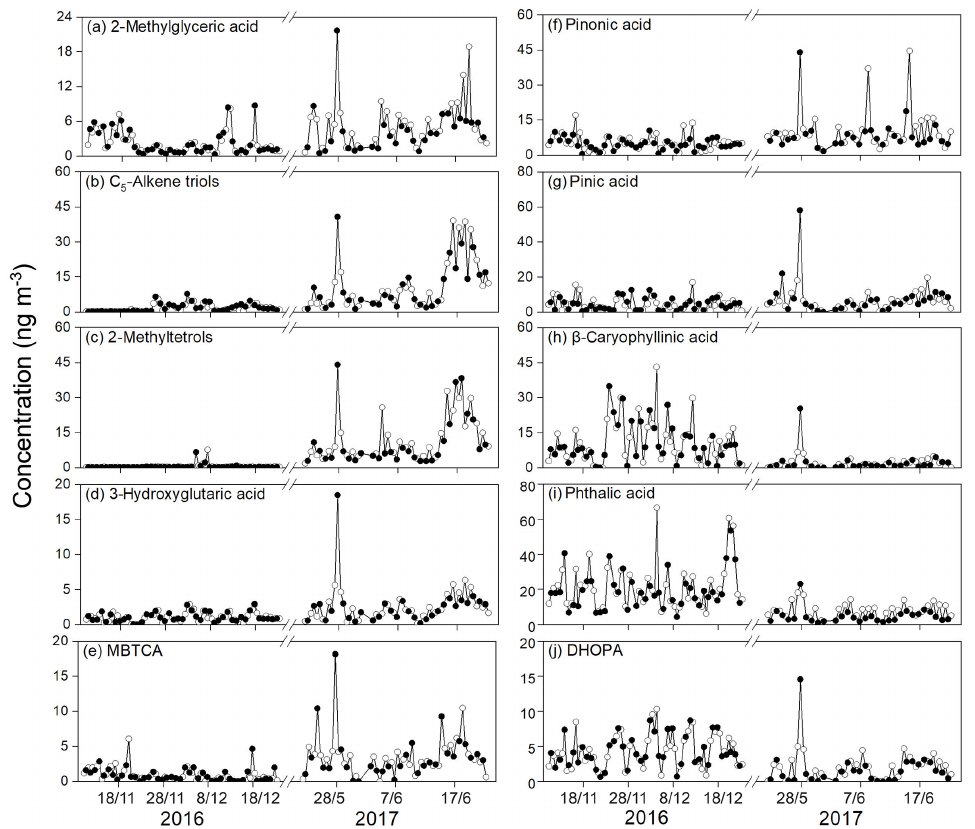
Figure 11. Temporal variations in isoprene-, monoterpene-, β -caryophyllene-, naphthalene-, and toluene-SOA tracers in PM 2 . 5 collected at Tianjin (white and black represent day- and night-time